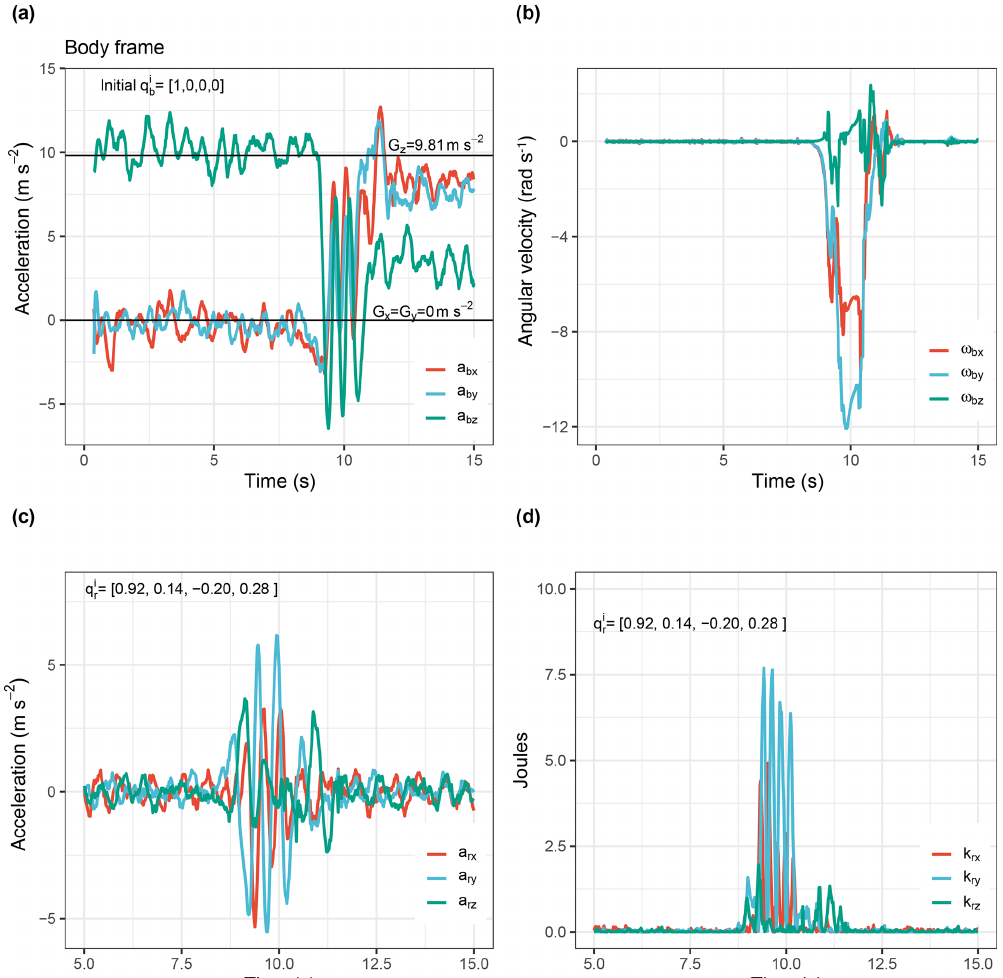
Figure B1. Example incipient motion IMU data. Measurements from the incipient motion experiments using the spherical sensor. (a) Un- filtered and uncompensated inertial acceleration measurements. The sensor is initially aligned to gravity, which results in the z axis of the accelerometer measuring a mean value of 9.81ms − 2 . (b) Angular velocity (rads − 1 ) measurements derived from the gyroscope. (c) Linear acceleration along the three-body-frame axis. This is the result of removing gravity from the inertial measurements shown in (a) and apply- ing a FFT high-pass filter as described in Maniatis (2016) (Sect. 6). Panel (d) shows the kinetic energy calculation after integrating once the m (cid:107) v r (cid:107) 2 + 1 I cm (cid:107) ω b (cid:107) 2 as described in Sect. signal presented in panel (c) and applying the formula K = 1 2 2